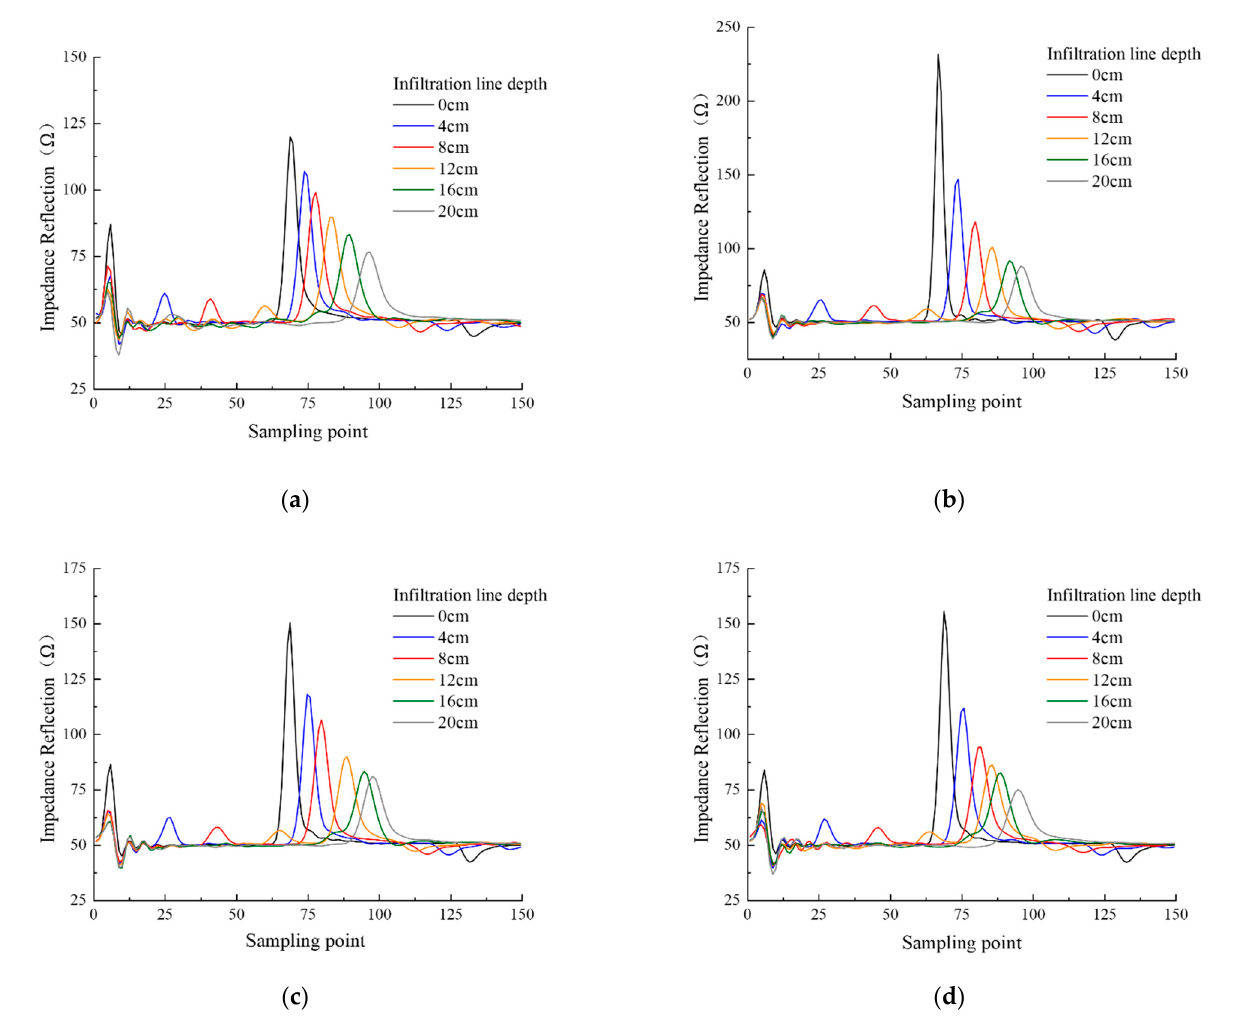
Figure 3. Measurement of infiltration lines with two layers for different soil: ( a ) Shaanxi Lou soil; ( b ) clay loam; ( c ) loess; ( d ) black soil.